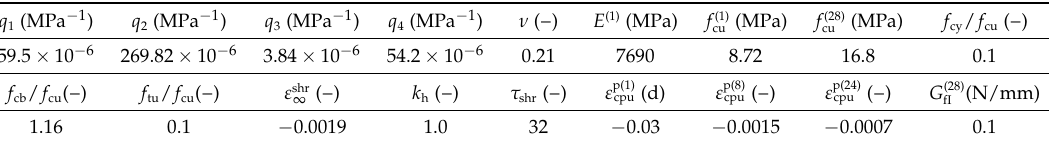
Table 1. Material parameters for the SCDP model.